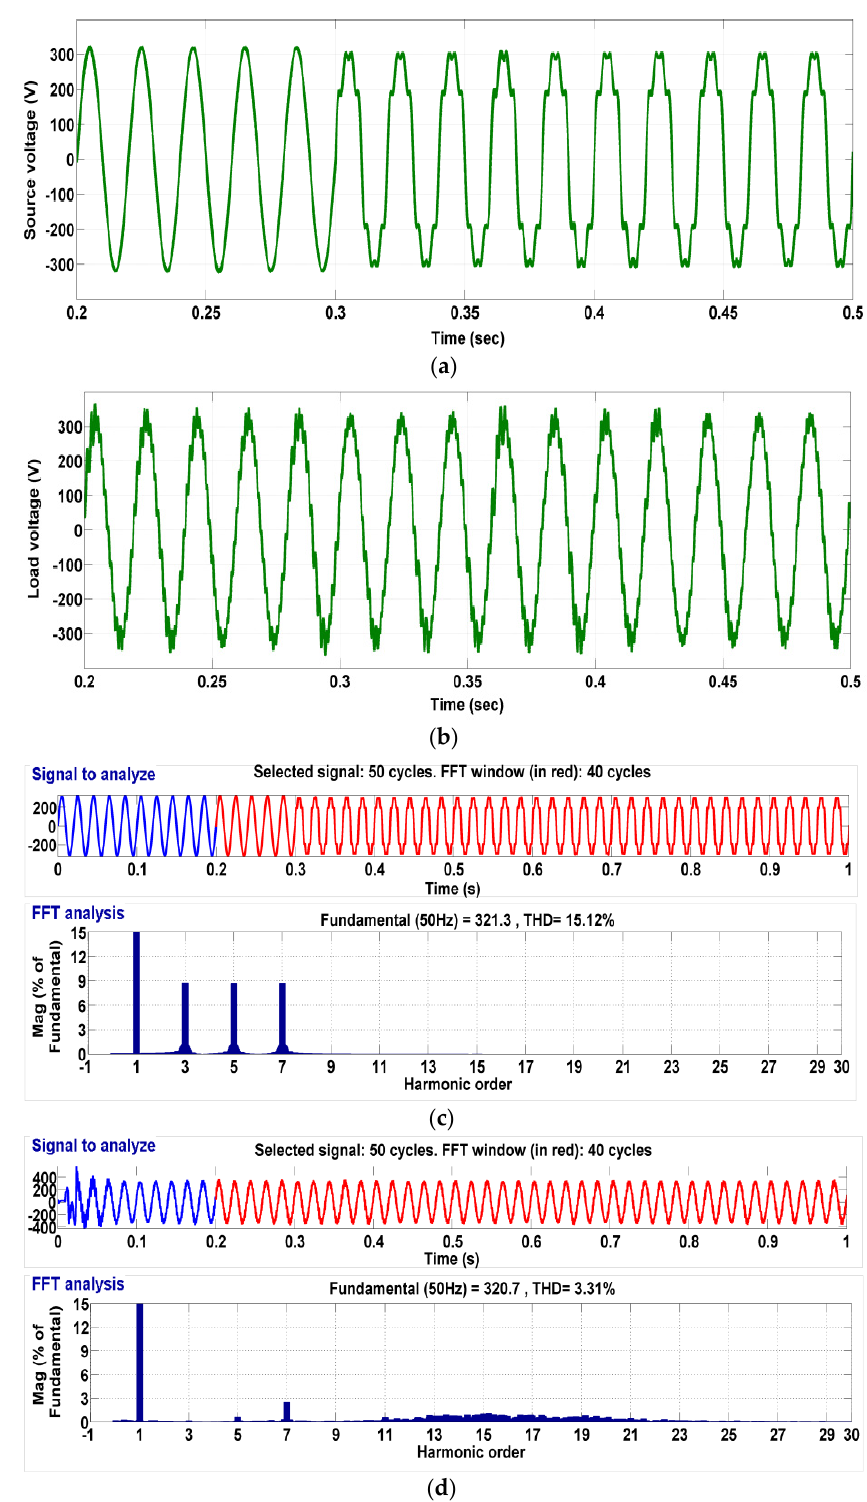
Figure 10. Voltage analysis with UPC system under harmonic conditions: ( a ) source voltage; ( b ) load voltage; ( c ) FFT analysis of source voltage; ( d ) FFT analysis of load voltage.